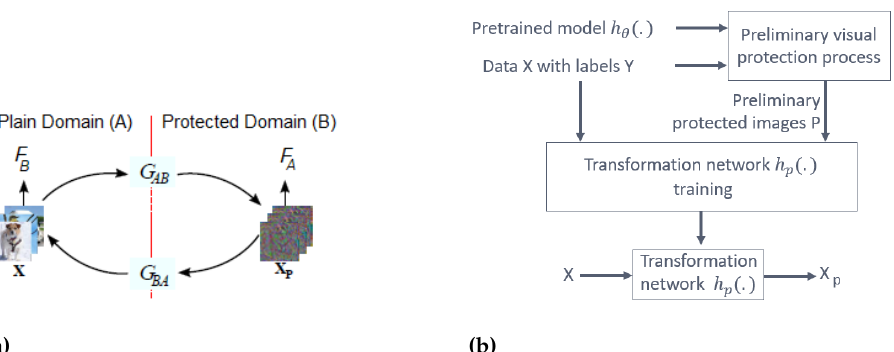
Figure 4. ( a ) Cycle-GAN architecture. ( b ) Training process of h p ( . ) in the TN-GAN-based method. © 2021 IEEE. Reprinted, with permission, from